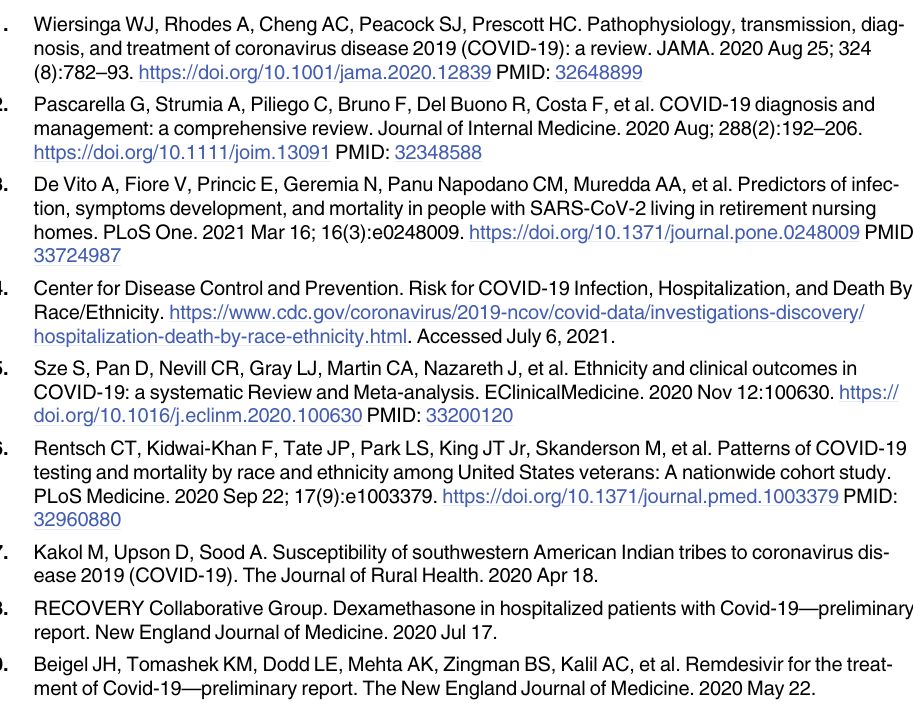
S8 Fig. Hazard ratio and 95% CI for the multi-state multivariable Cox regression model for discharge to re-hospitalization transition adjusted for comorbidities and other patient characteristics at admission (model 2). N = 6240; 15 observations deleted due to missingness in median household income. BMI: Body mass index; CI: Confidence interval; Site 1 (n = 1762), Site 2 (n = 1048), Site 3 (n = 1030), Site 4 (n = 1163), Site 5 (n = 1252) are unique